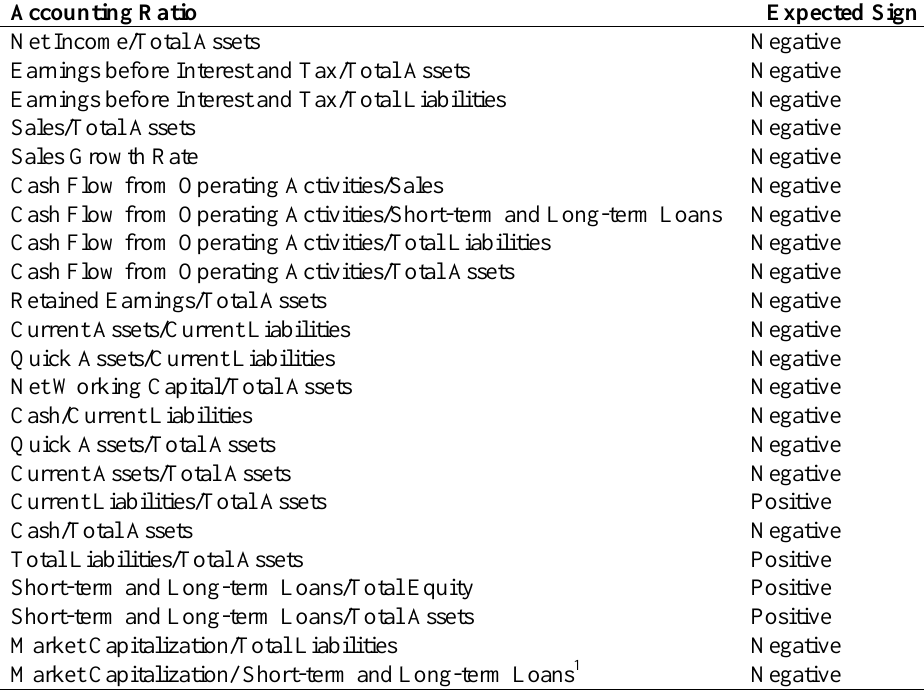
Table (1). Accounting Ratios Affecting Corporate Default Accounting Ratio Expected Sign Net Income/Total Assets Earnings before Interest and Tax/Total